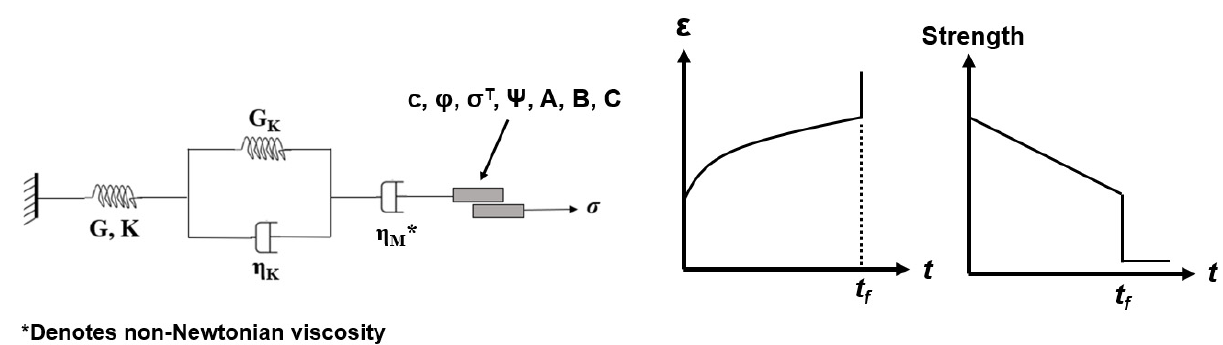
Figure 16. Conceptual schematic of the LTS model.